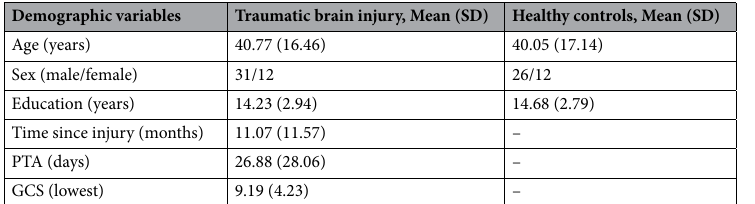
Table 1. Demographic information and clinical characteristics of the TBI and healthy groups. GSC Glasgow Coma Scale, PTA post-traumatic amnesia. PTA duration were available for n = 41 patients; GCS were available for n = 42